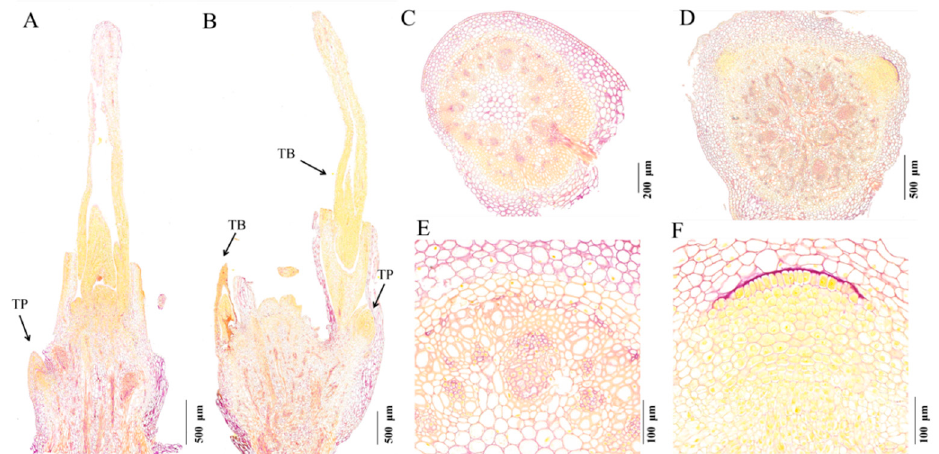
Figure 2. The distribution of starch (purple) and protein (yellow) in wheat tillers of WT and dmc at the three-leaf stage. Tiller histological section micrographs of WT ( B , D , F ) and mutant dmc ( A , C , E ). ( A ) Longitudinal section of the tiller bud of dmc (arrowhead); ( B ) Longitudinal section of tillers of WT (arrowheads); ( C ) Transection of the tiller base of dmc ; ( D ) Transection of the tiller base of WT; ( E ) An enlarged view of C; ( F ) An enlarged view of D. TP: tiller primordium; TB: tiller bud.